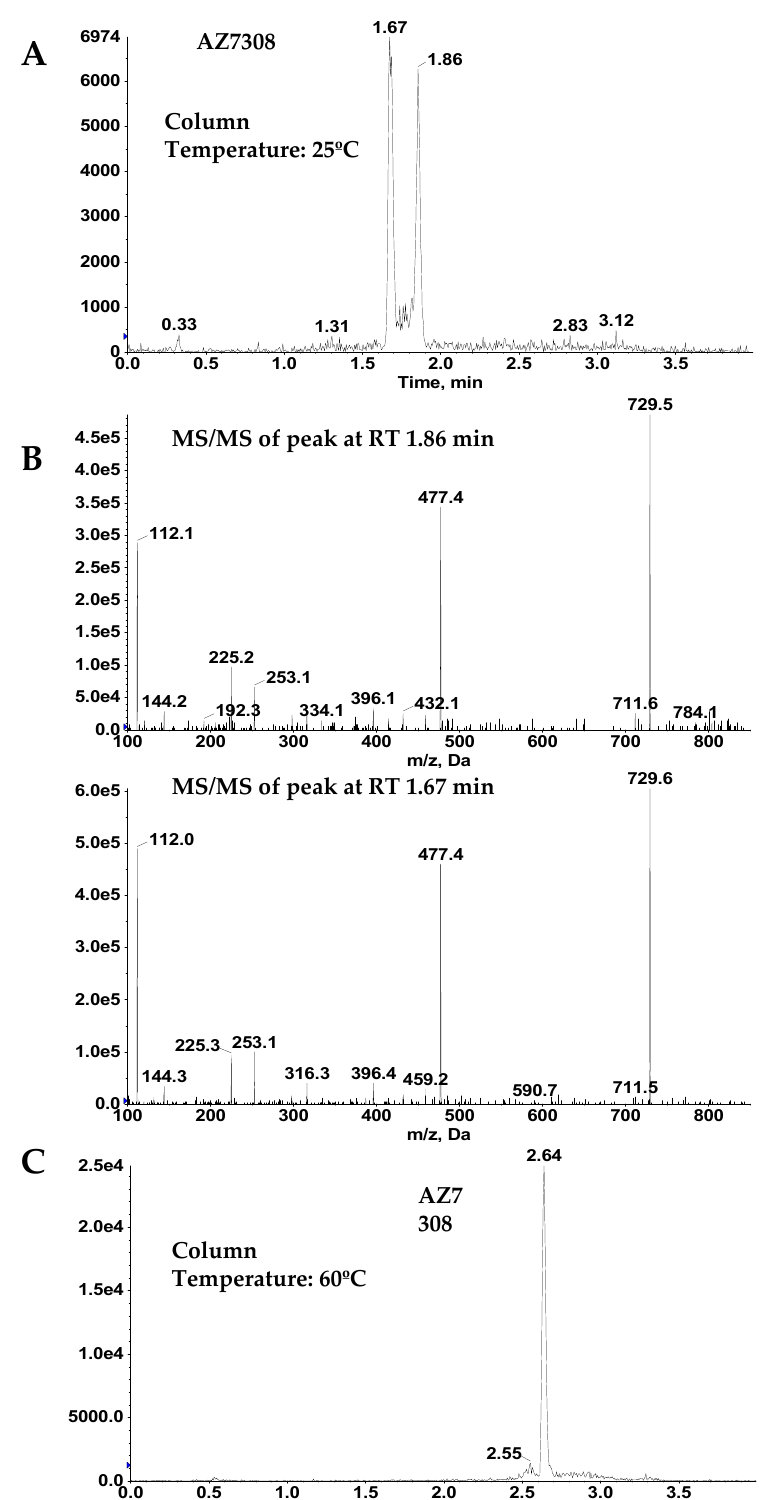
Figure 6. Effect of column temperature on AZ13687308 (AZ7308) peak shape. ( A ) Peak split observed at 25 ◦ C. ( B ) Mass spectrometric fragmentation spectra of the two peaks observed in ( A ). ( C ) Single peak observed at 60 ◦